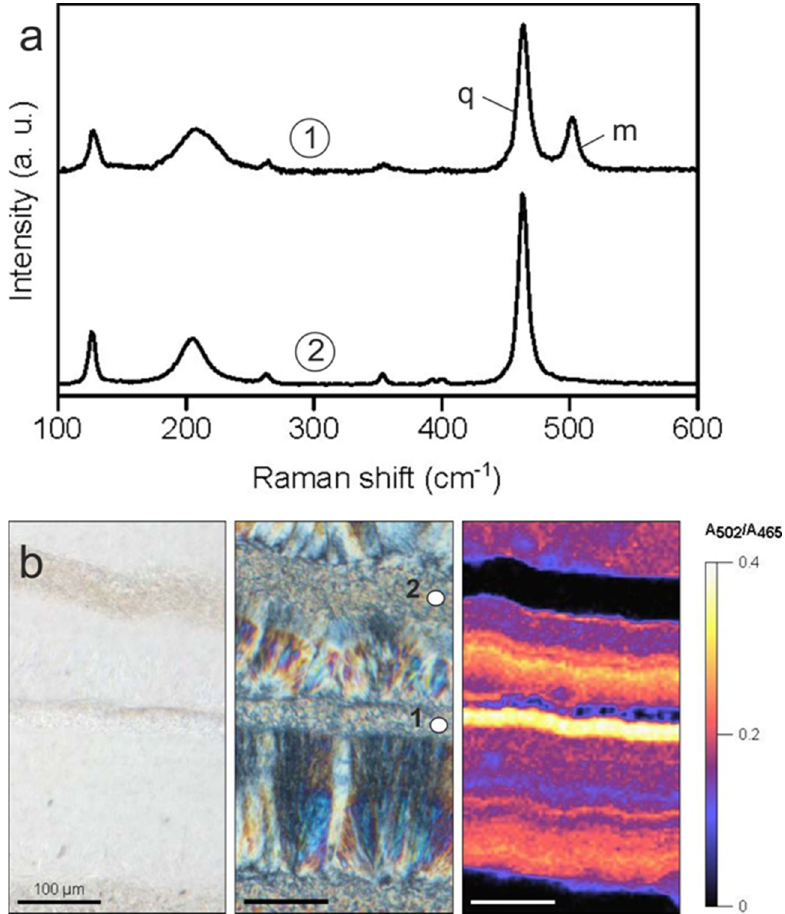
Figure 9. Results of Raman spectroscopy and Raman mapping of agate sample ACu1: ( a ) Raman spectra of two local analyses in different agate areas (compare b); spectrum 1 shows the characteristic main symmetric stretching-bending vibrations (A 1 modes) of alpha-quartz (q) at 465 cm − 1 and moganite (m) at 502 cm − 1 , respectively; whereas spectrum 2 shows only the band of alpha-quartz; ( b ) agate area in transmitted light with parallel and crossed polars, respectively, and the related Raman map based on the integral ratio of the 502/465 cm − 1 bands; high ratios (yellow) point to areas with high moganite content.